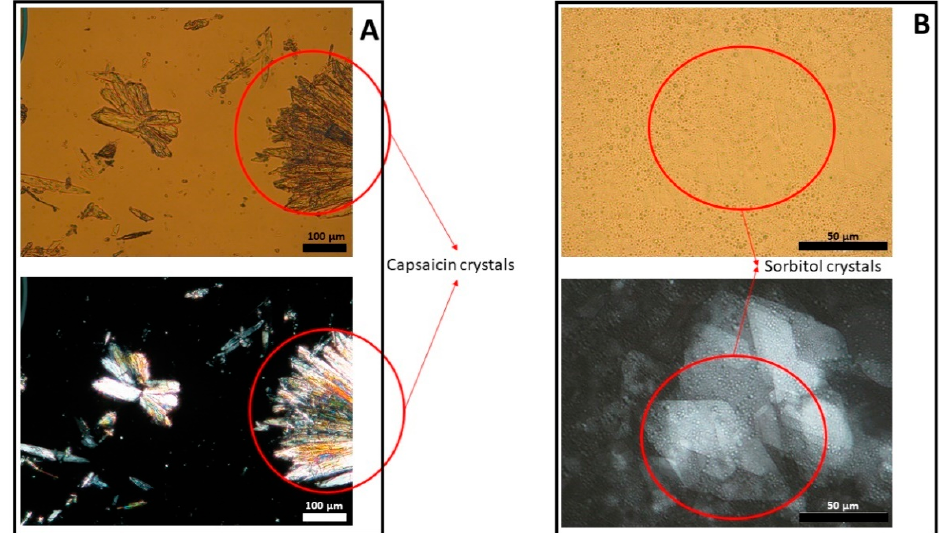
Figure 4. Light (upper panel) and polarized (lower panel) microscope images of capsaicin suspended in isopropyl myristate (panel A ) and a placebo emulsion (panel B ).